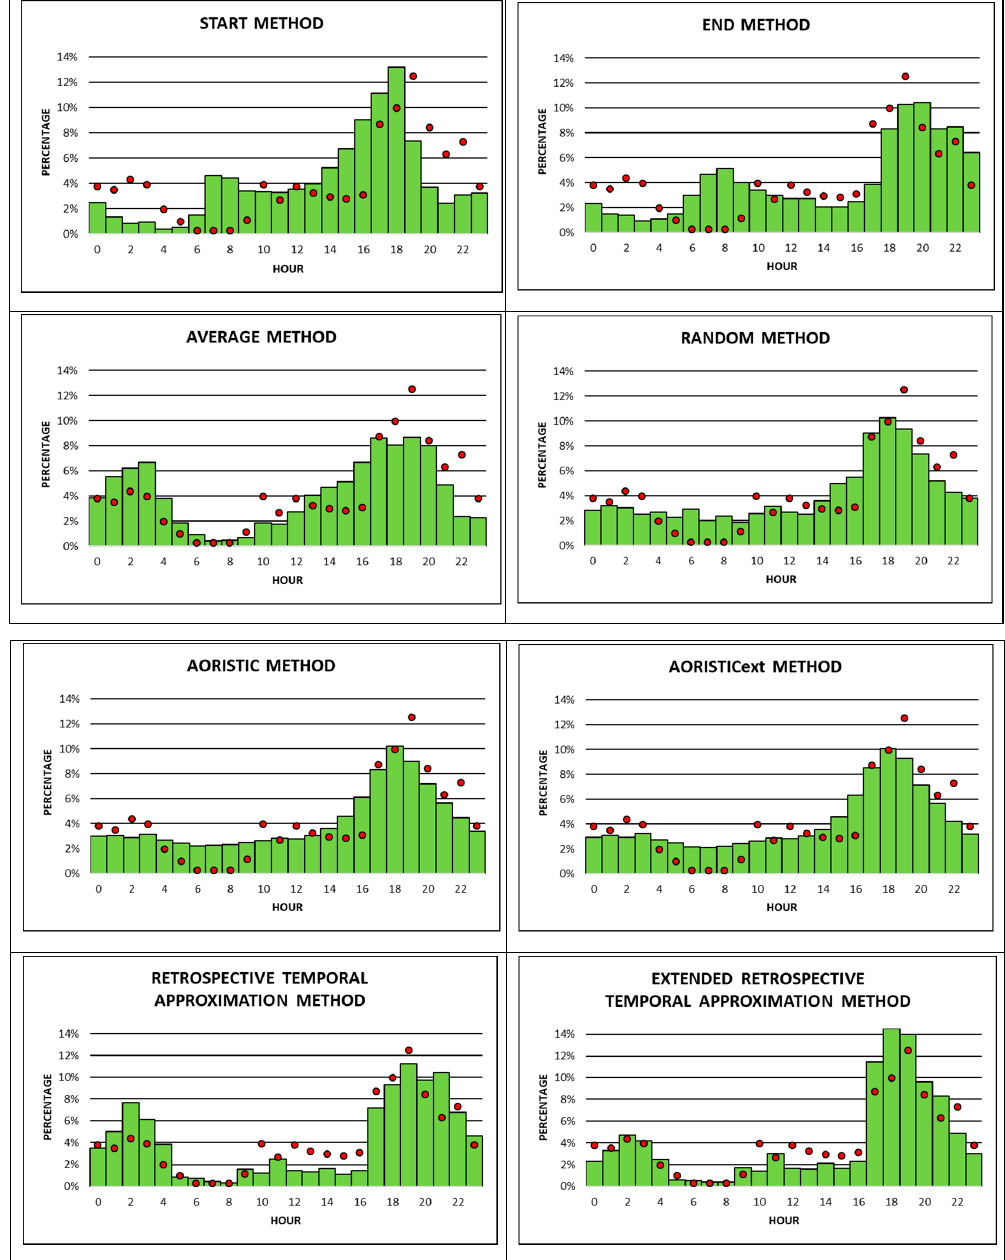
Figure 6. Comparing observed (red dots) and estimated (green bars) occurrence times of house burglaries in Vienna, Austria between 2013–2015.